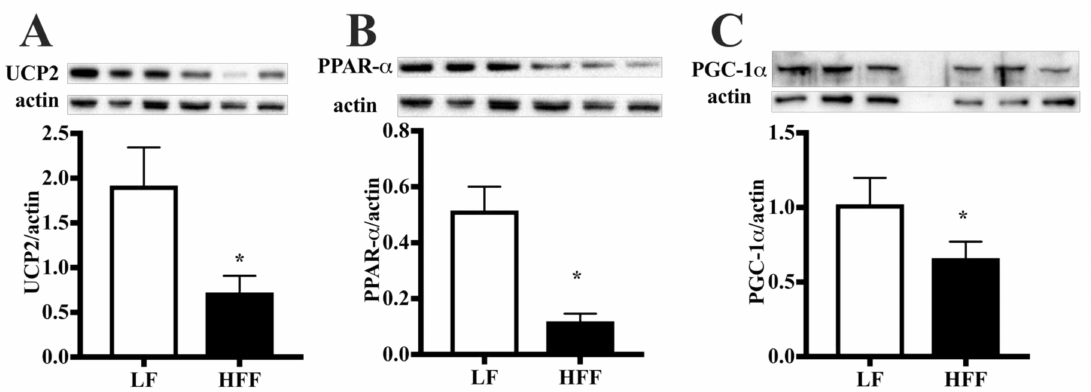
Figure 2. Protein content (with representative western blot) of uncoupling protein 2 (UCP2) ( A ), peroxisome proliferator activated receptor alpha (PPAR- α ) ( B ) and peroxisome proliferator-activated receptor gamma coactivator 1-alpha (PGC-1 α ) ( C ) in epididymal white adipose tissue (e-WAT) from middle-aged rats fed low fat (LF) or high fat-high fructose (HFF) diet for four weeks. Values are the means ± SEM of eight rats. * p < 0.05 compared to low-fat diet (two-tailed Student’s